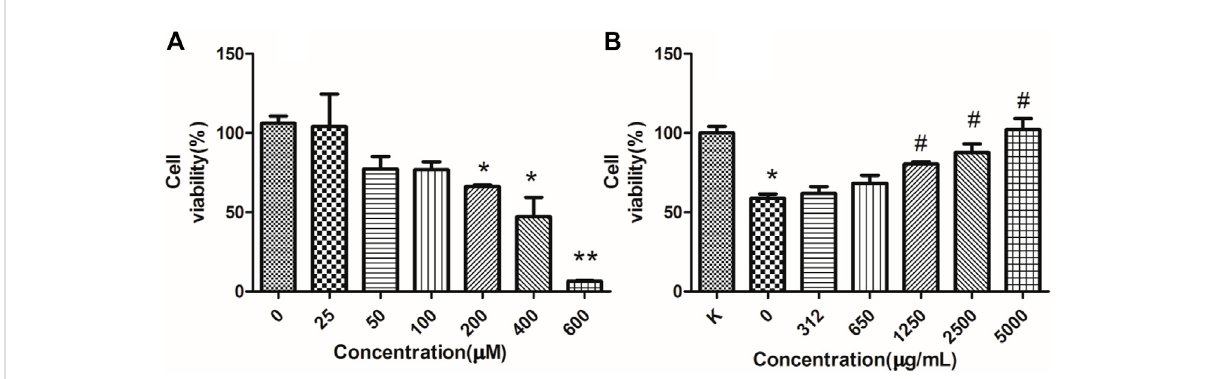
FIGURE 9 RFP protect against H 2 O 2 -induced cytotoxicity. (A) H 2 O 2 -induced cytotoxicity. NRK-52E cells were treated with different concentrations of H 2 O 2 as indicated for 18 h. (B) RFP inhibited the cell death induced by H 2 O 2. NRK-52E cells were pretreated with different concentrations of RFP for 24h, then exposed with H 2 O 2 for 18 h. The cell viability was assessed by MTT ( ‾ x± SD, n = 3). * p < 0.05, ** p < 0.01 as compared to the control. # p < 0.05 as compared to cells only treated with H 2 O 2 , without RFP solutions.